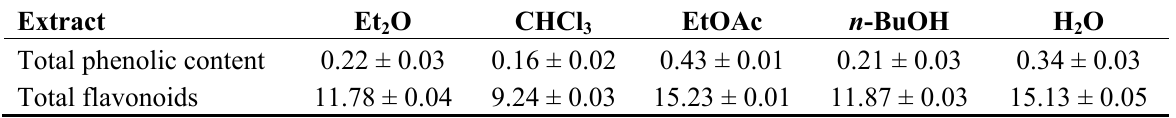
Table 1. The amount of total phenolic contents and content of total flavonoids in T. pratense extracts. Extract Et O CHCl EtOAc n -BuOH 2 3 Total phenolic content Total phenolic content is expressed in mg GAE/g d.e. ± S.D; Content of total flavonoids is expressed in  g RE/g d.e. ±